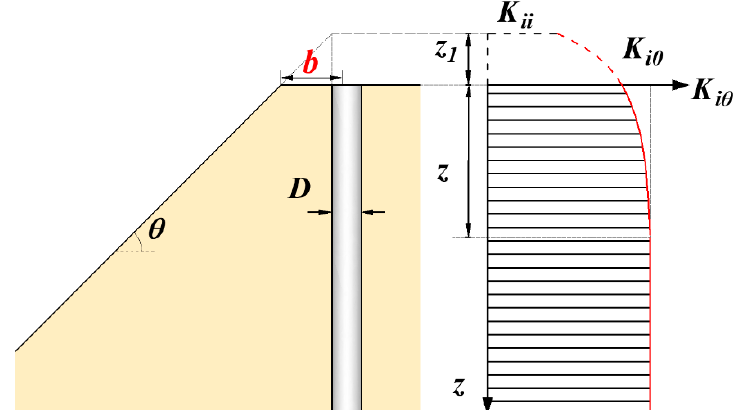
Figure 4. Transition from a pile at the slope crest to a pile near the slope crest.